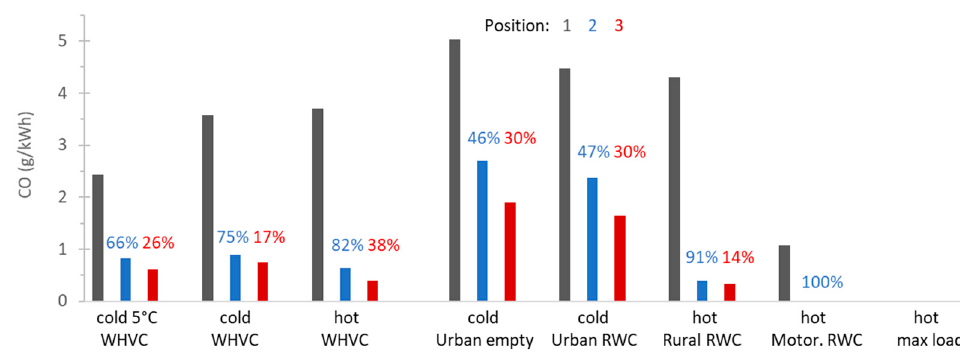
Figure 7. CO emission factors for various cycles at different sampling positions of the aftertreatment system. Position 1 (engine out, grey bars); position 2 (DOC + cDPF out, blue bars); position 3 (SCR + ASC out, tailpipe, red bars). Percentages give emissions reductions compared to the previous position. Tests at 23 °C, except “cold 5 °C WHVC”, and 66% of maximum payload, except “Urban empty” (9%). “Cold” and “hot” refer to the coolant temperature at engine cranking, i.e., at ambient temperature or >70 °C, respectively. ASC = ammonia slip catalyst; DOC = Diesel oxidation catalyst; cDPF = catalyzed Diesel particulate filter; RWC = real-world cycle; SCR = selective catalytic reduction; WHVC = world harmonized vehicle cycle.